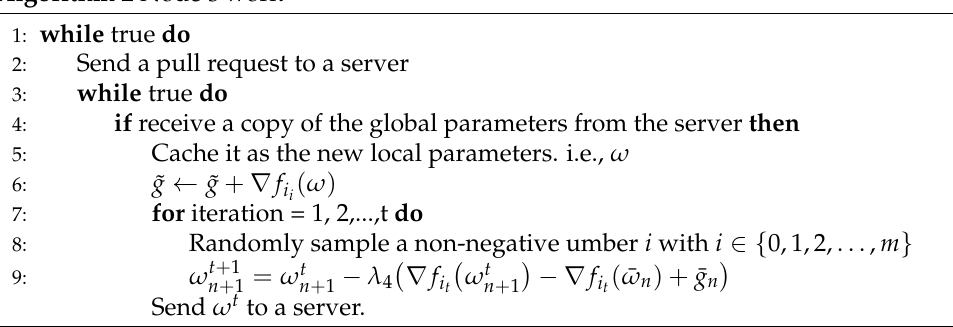
Algorithm 2 Node’s work